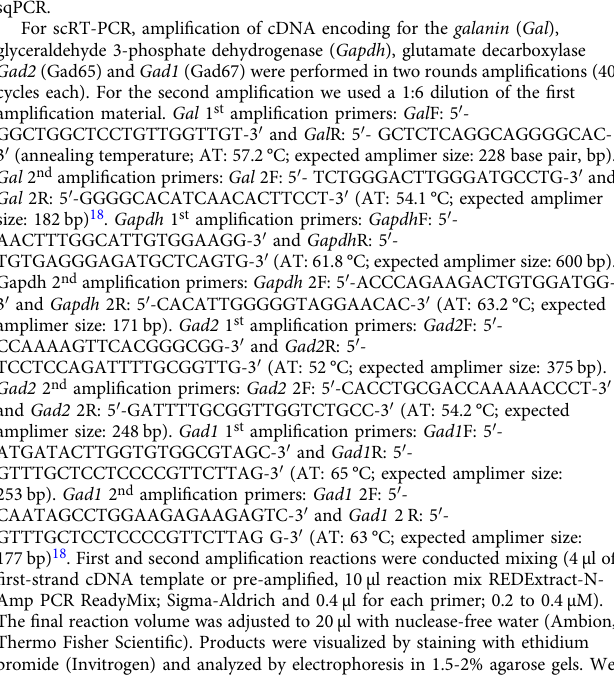
Figure 1d: an example of double labelling for ChR2-mCherry and Ox-A immu- noreactivity to test selectivity of the AAV-DIO-ChR2-eYFP (and AAV-DIO-ChR2- mCherry ) for Ox neurons. Immunolabeling conducted in n = 4 Ox-IRES-Cre mice injected with AAV-DIO-ChR2-eYFP (and AAV-DIO-ChR2-mCherry ) into the Ox fi eld. Figure 2a and b: map of n = 29 recorded neurons distributed in n = 19 slices from n = 14 WT mice. Figure 4a: an example of VLPO GABA neurons (in green) and VLPO GABA/Gal neurons (double-labeled in red and green) following the injection of a mix of AAV-fDIO-ChR2-eYFP and AAV-DIO-TdTomato into